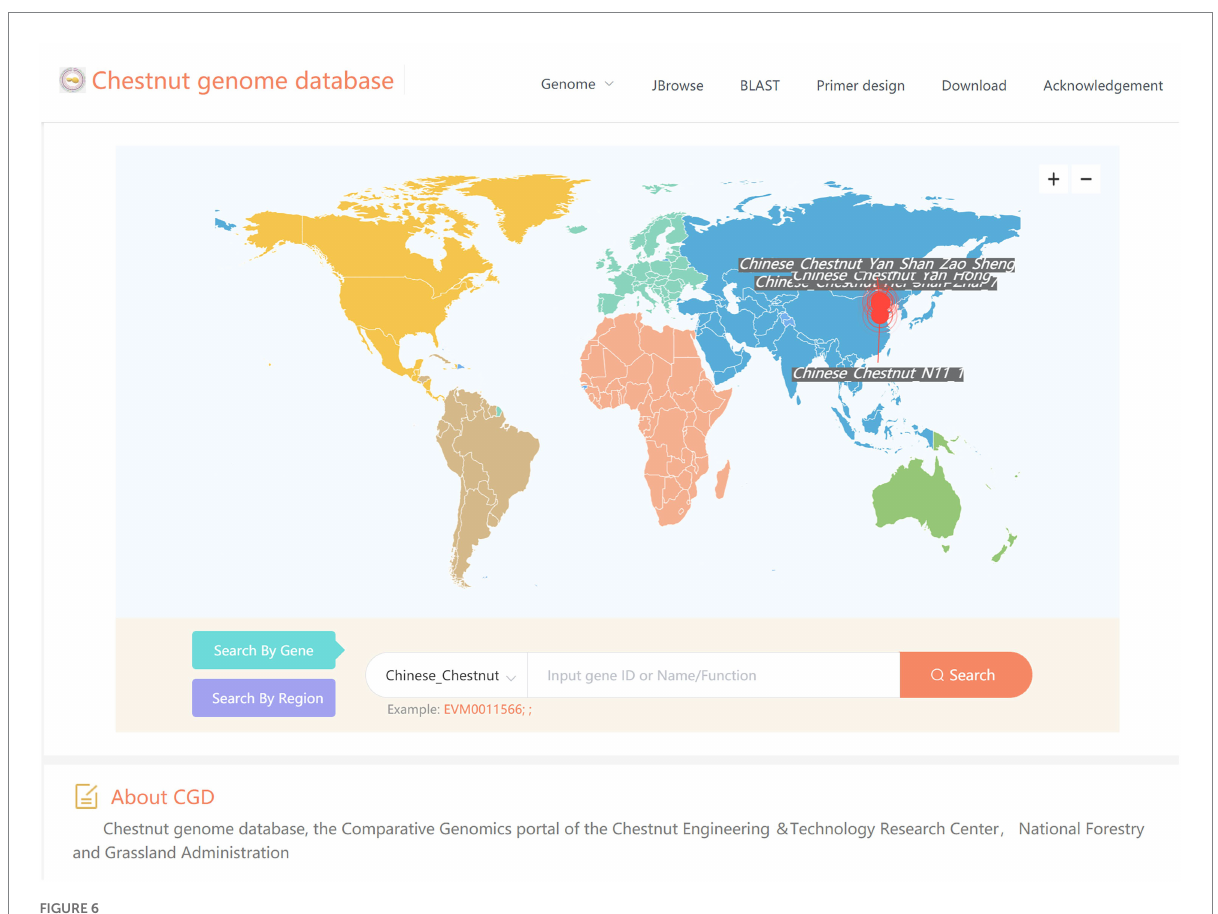
FIGURE 6 The user interface of Chestnut Genome Database for browsing genomes, searching for homologous sequences and designing